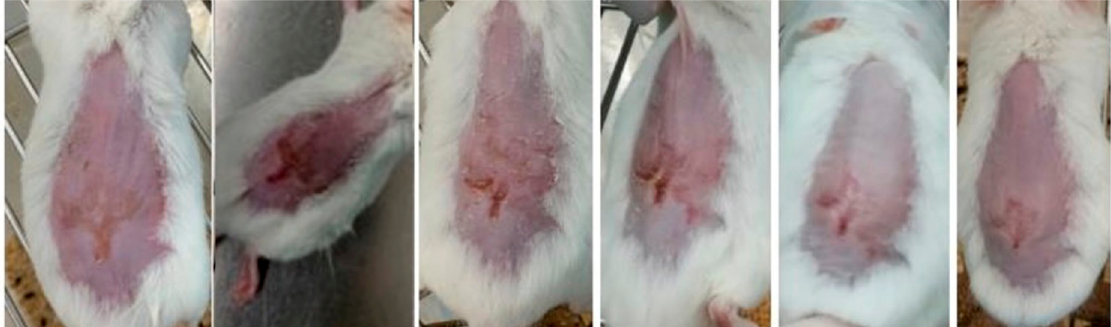
Figure 8. Progress of skin healing in the group treated with Pluronic ® F127 hydrogel (from day 3 to day 8, following the course of treatment).